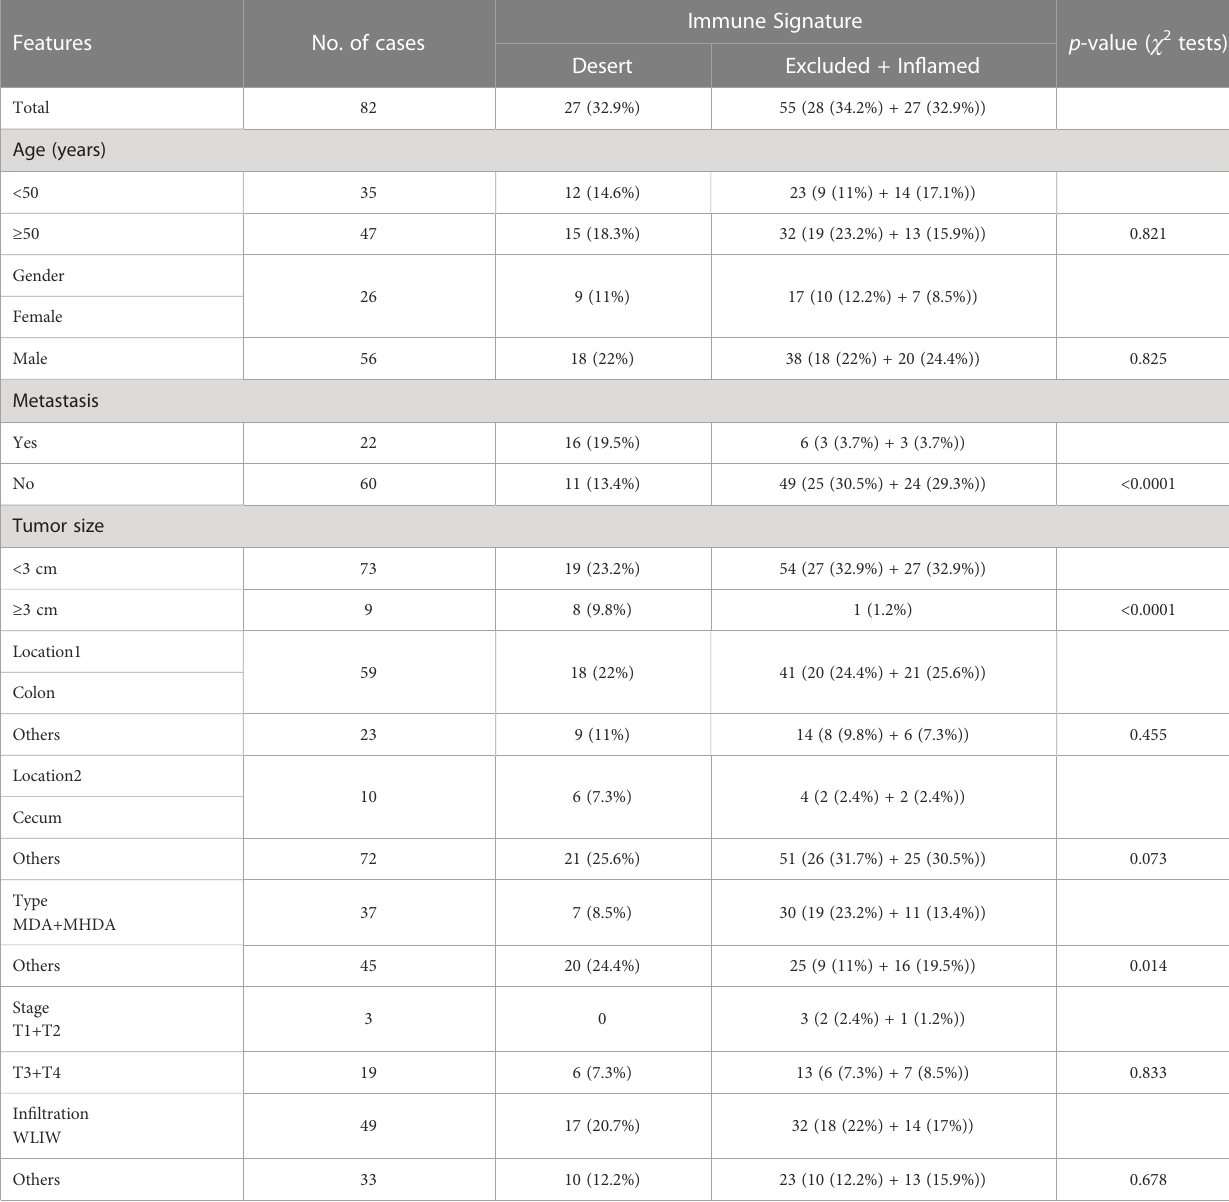
TABLE 1 The correlation between immune signature and pathologic features in patients with MMR de fi ciency.